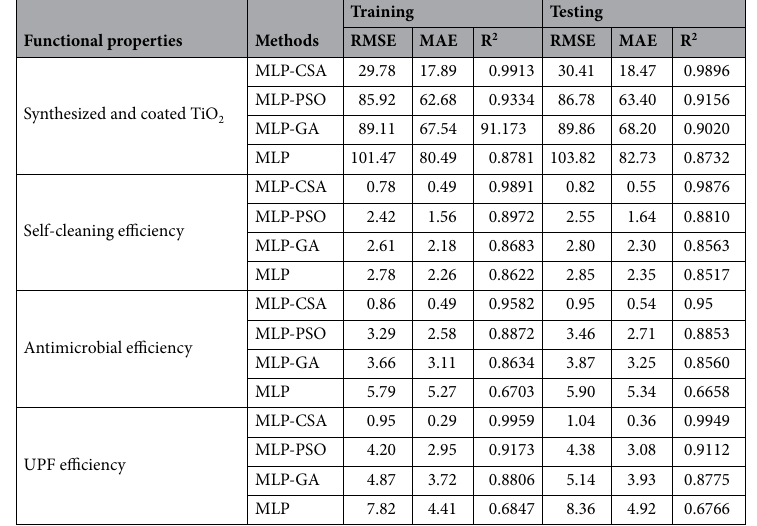
Table 3. Errors of different approaches.